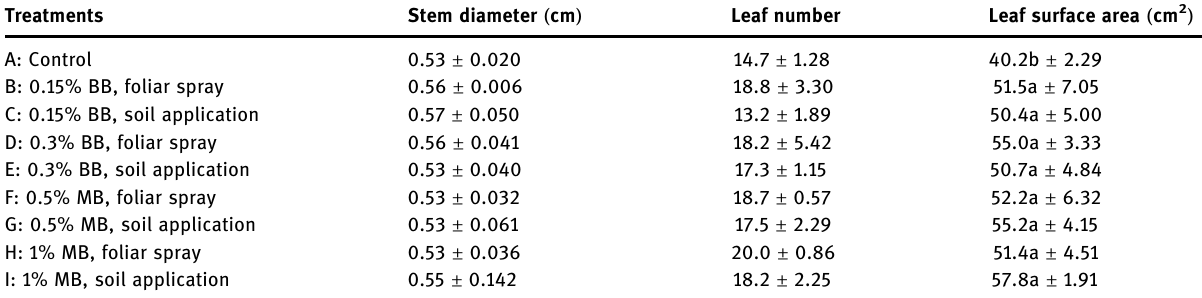
Table 2: E ff ect on biofertilizer on leaf number and leaf surface area of nutmeg seedlings at 24 weeks after transplanting in the greenhouse Treatments Stem diameter ( cm ) Leaf number Leaf surface area ( cm 2 )